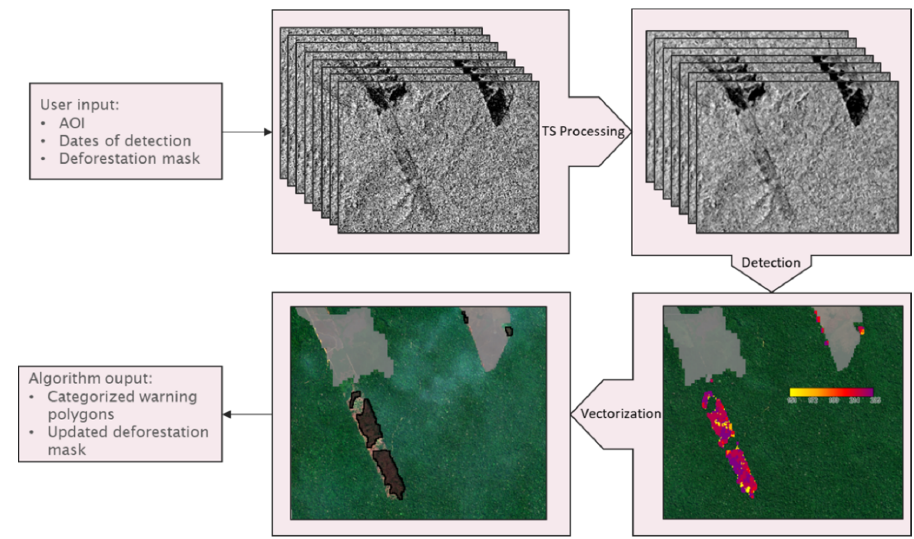
Figure 14. Proposed operationalization of the reviewed methods.